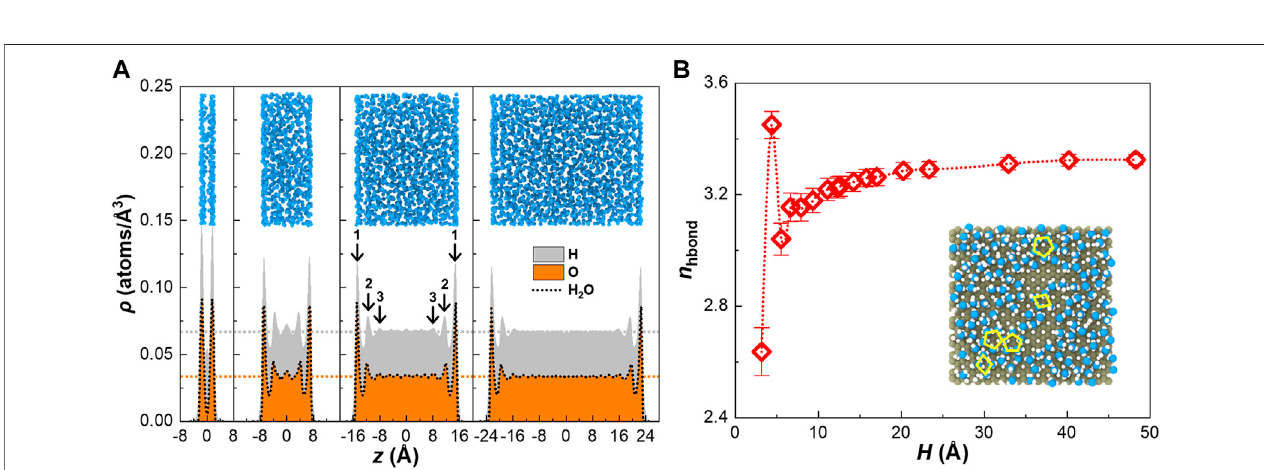
FIGURE 3 | Density distribution and mean coordination number of hydrogen bond of water. (A) Density distribution of water perpendicular to the wall varies with channel height; the dotted horizontal lines refer to the bulk value; peaks corresponding to water layers are labeled with numbers; snapshots are con fi gurations of water molecules represented by oxygen atoms, where water layers appear at two sidesnear the wall. (B) Mean coordination number of hydrogen bonds of water depends on the channel height; snapshot is the top view of the fi rst water layer.